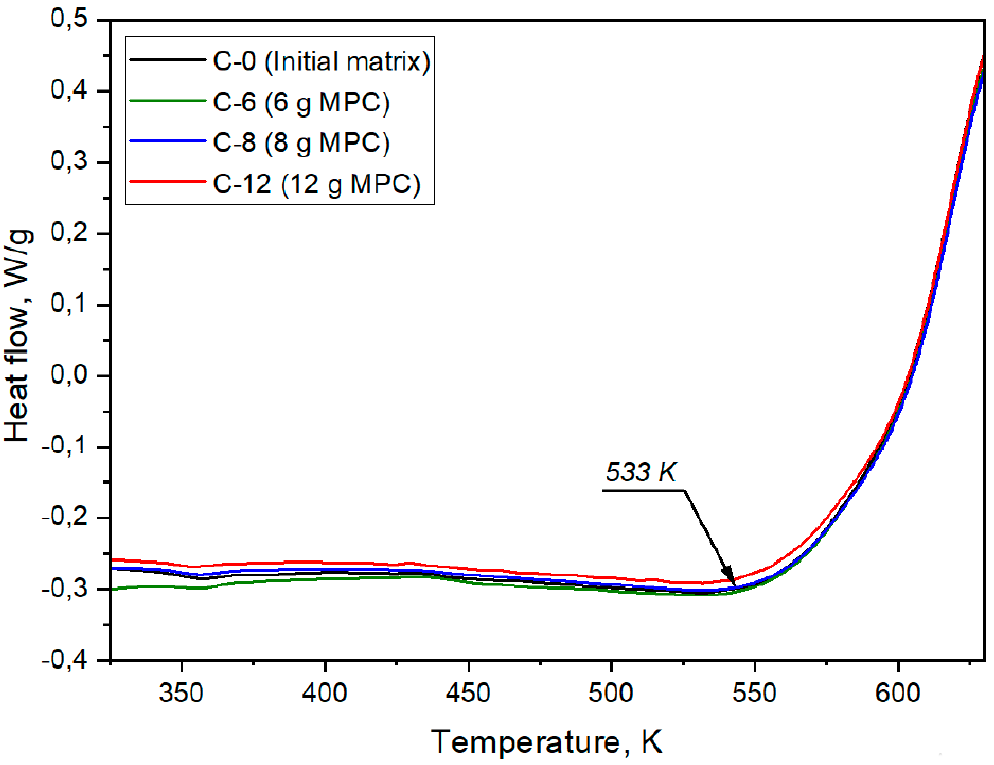
Figure 3. DSC curves of the obtained composites.